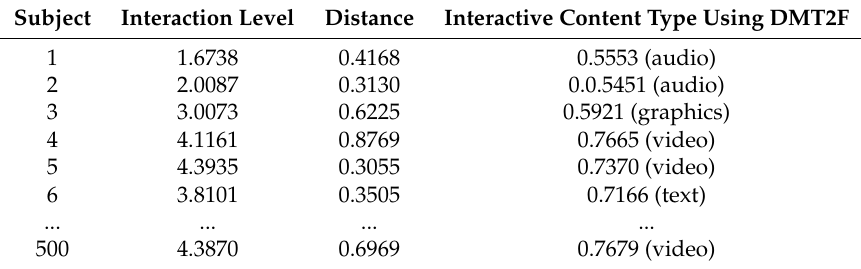
Table 4. Results of the interactive content type using the data mined Type-2 fuzzy method